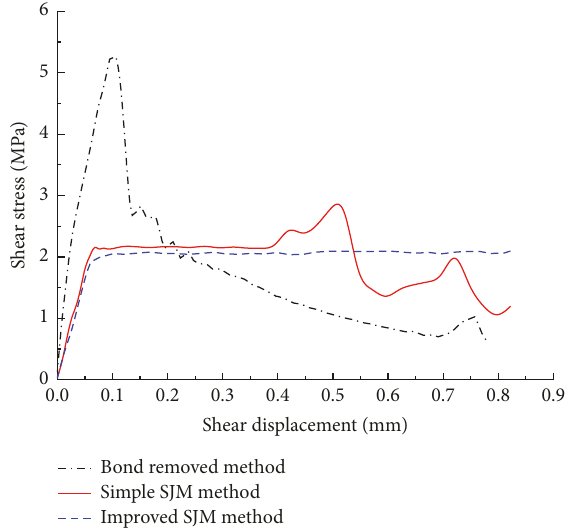
Figure 3: Shear stress-shear displacement curves from the three different bedding planes modeling